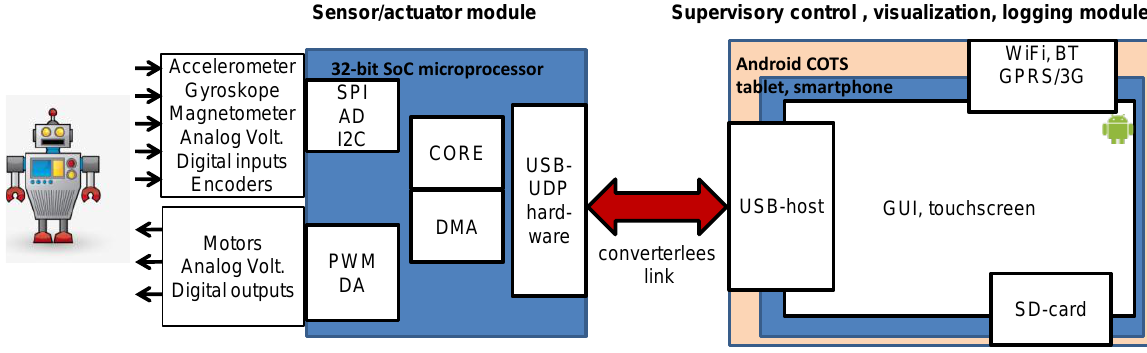
Figure 1. Proposed hardware